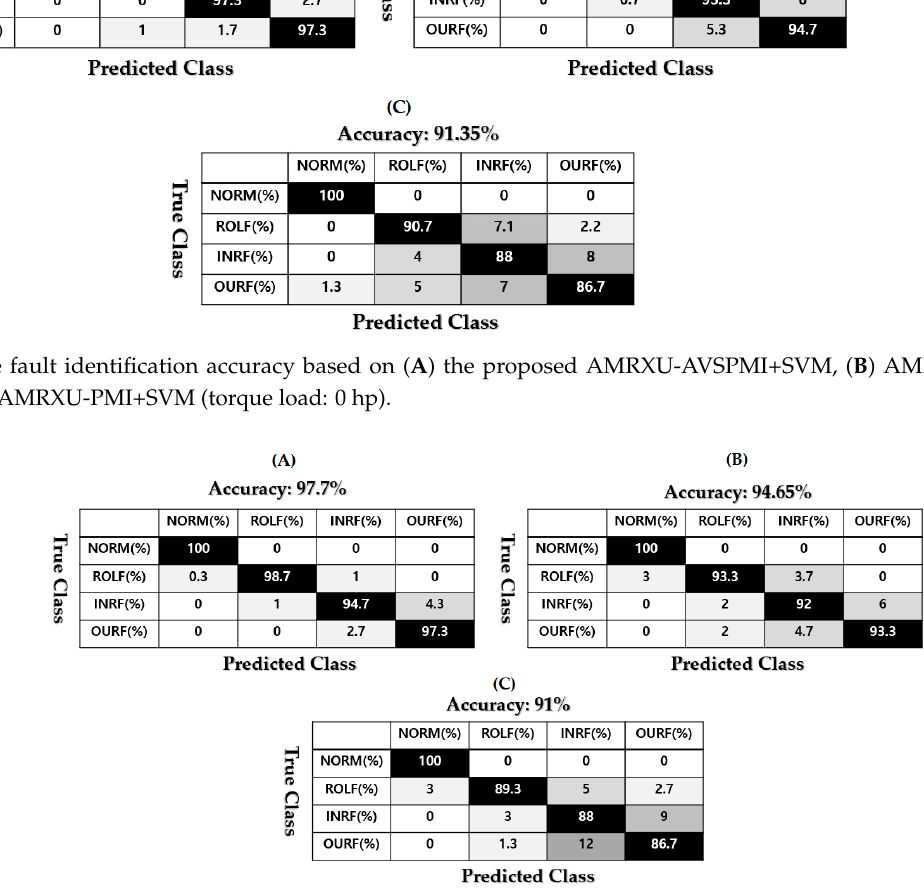
Table 7. The accuracy of state identification (torque load: 2 hp).